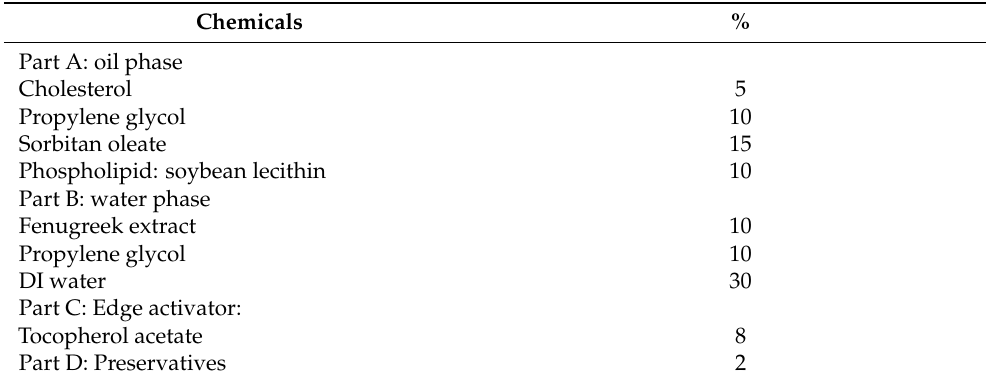
Table 2. Chemical components of formulated